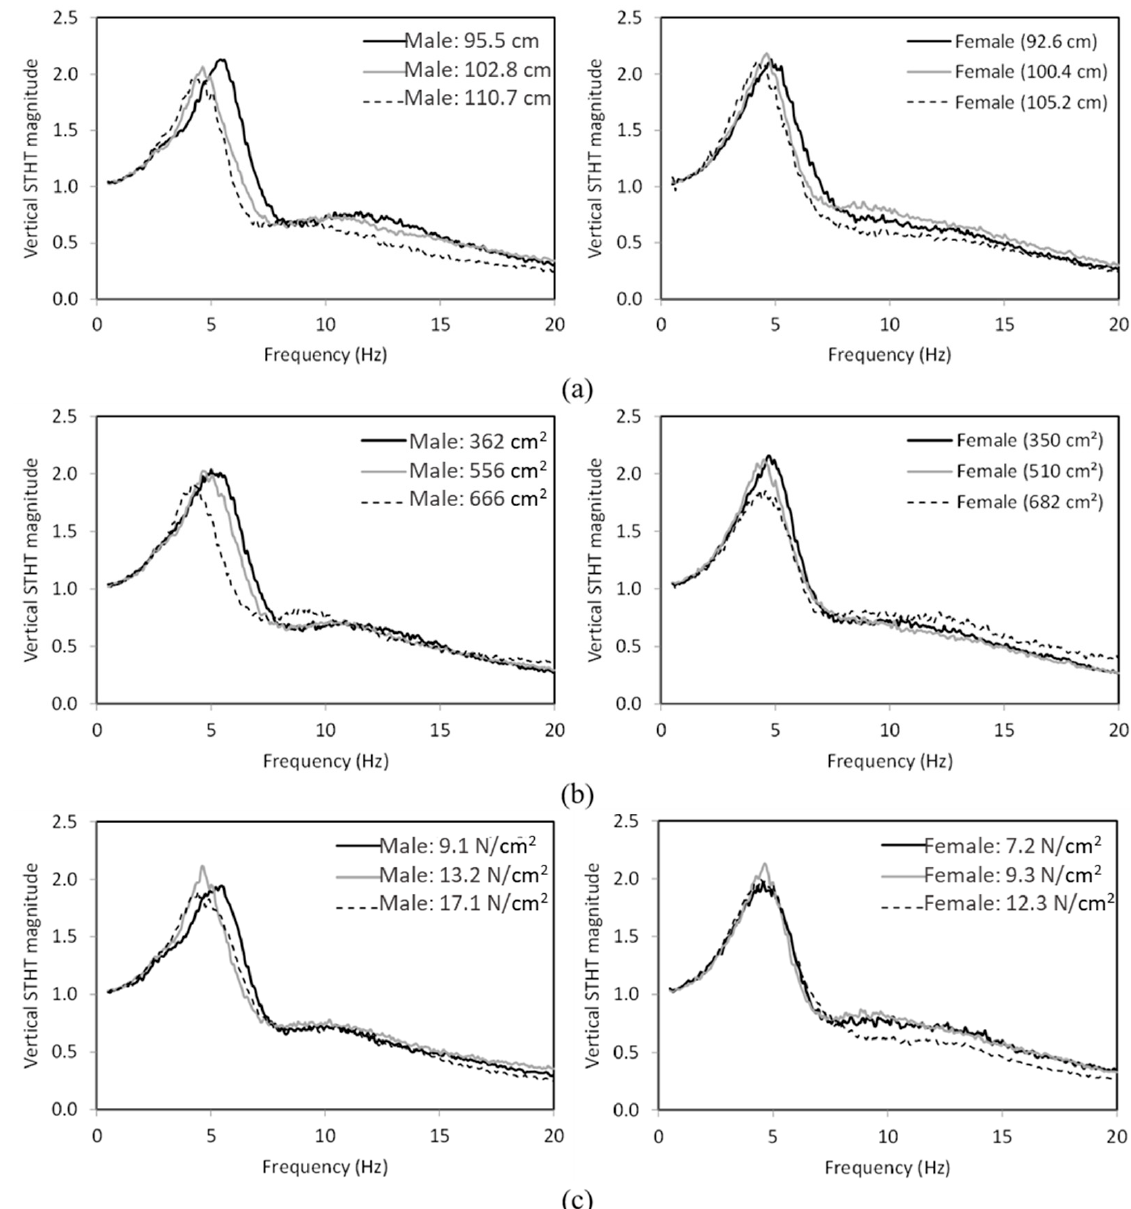
Figure 13. Influences of hip circumference, effective body-seat contact area, and mean contact pressure on mean vertical STHT magnitudes of males and females: ( a ) hip circumference; ( b ) seat–pan contact area; and ( c ) mean contact pressure (NB support, 0.50 m/s 2 excitation).